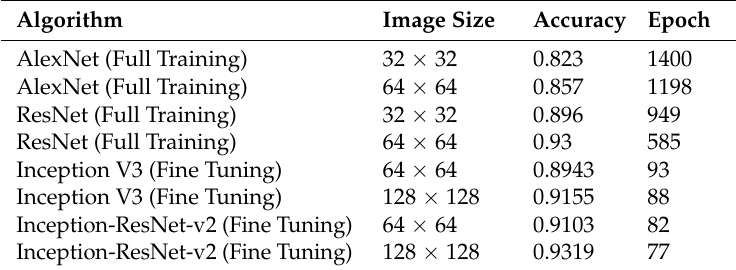
Table 6. Comparison of the accuracy results obtained in the different tests performed.